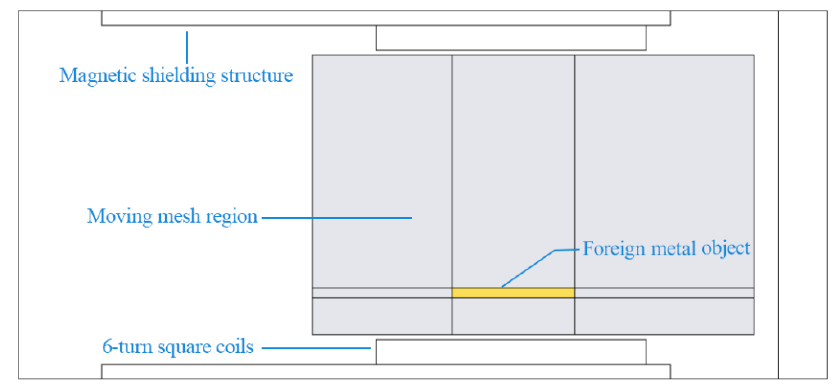
Figure 2. Finite-element solution model for dynamic characteristic of foreign metal objects.